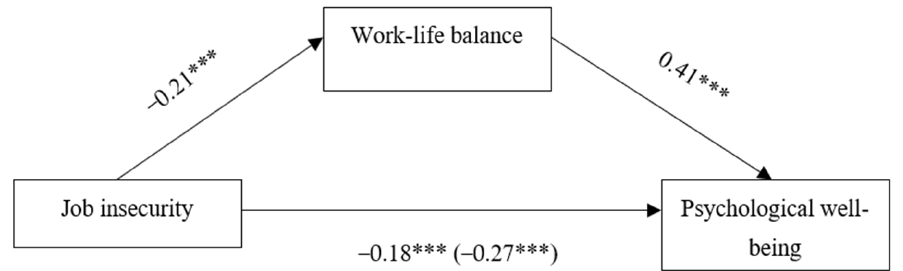
Figure 2. Mediation model showing the effect of job insecurity and work–life balance on psychological well-being. The values shown are unstandardised coefficients. The total effect is shown in the parentheses. *** p < 0.001.